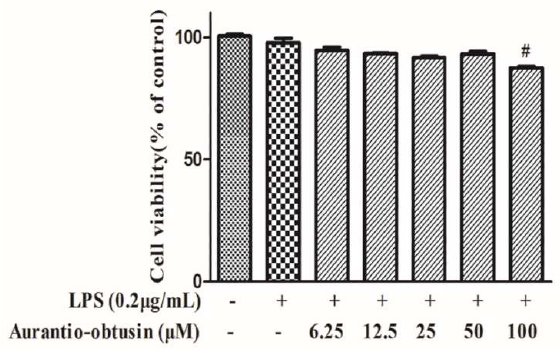
Figure 2. Effects of aurantio-obtusin on the cell viability of RAW264.7 cells. RAW264.7 cells incubated with various concentrations of aurantio-obtusin (6.25–100 μM) for 24 h followed by 0.2 μg/mL LPS stimulation. Cell viability was then measured using an MTT assay. # p < 0.05 represent significance when compared to the control cells.